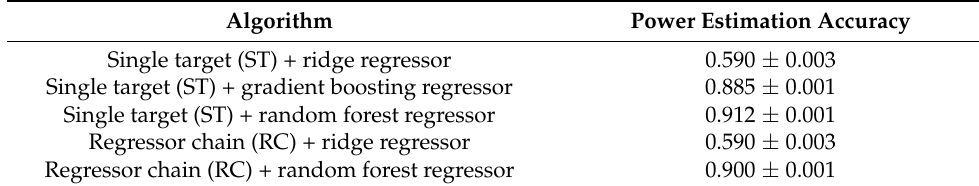
Table 7. Power estimation accuracy by different MTR algorithms.